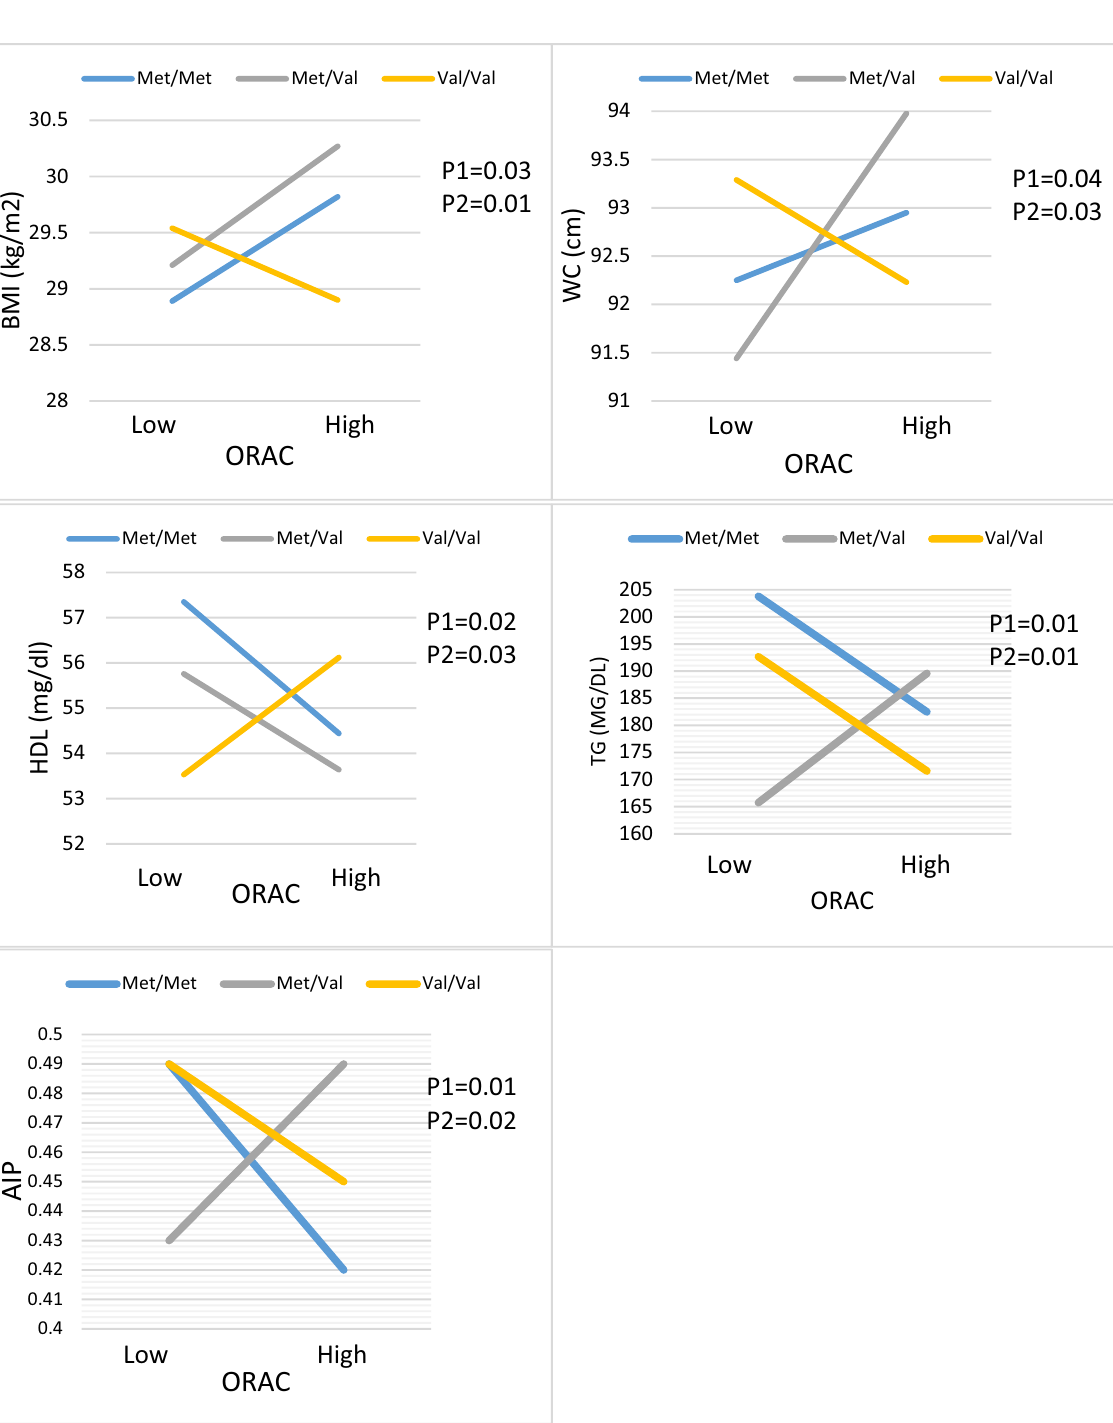
Figure 2. Interaction between the BDNF Val66Met polymorphism and DTAC (ORAC) intake with regard to TG, HDL, AIP and AC according to the median DTAC, the participants were dichotomized into low and high categories. P 1 = P value with unadjusted (crude) model, P 2 = P value with adjustments for potential confounding factors including (Age, physical activity, sex, smoking, alcohol, energy intake, lipid, and glucose- lowering medicines, and family history of